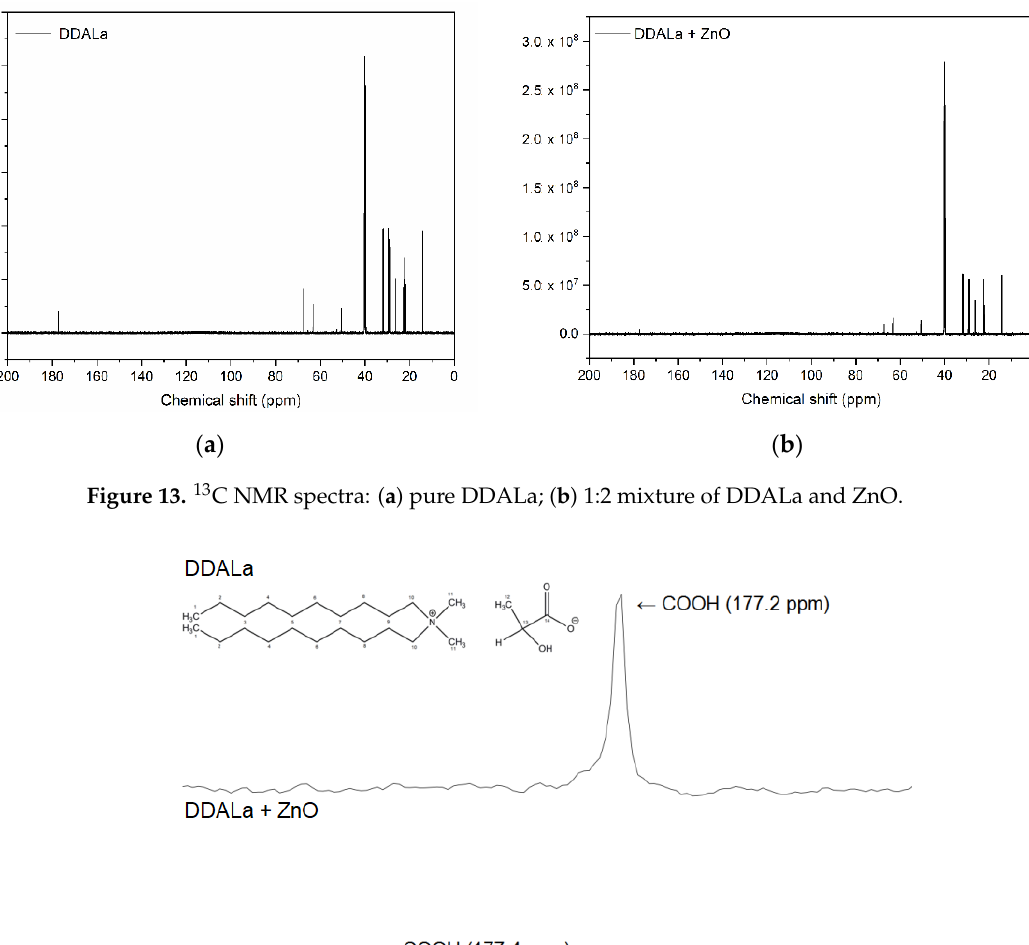
Figure 12. 1 H Nuclear Magnetic Resonance (NMR) spectrum for pure DDALa.